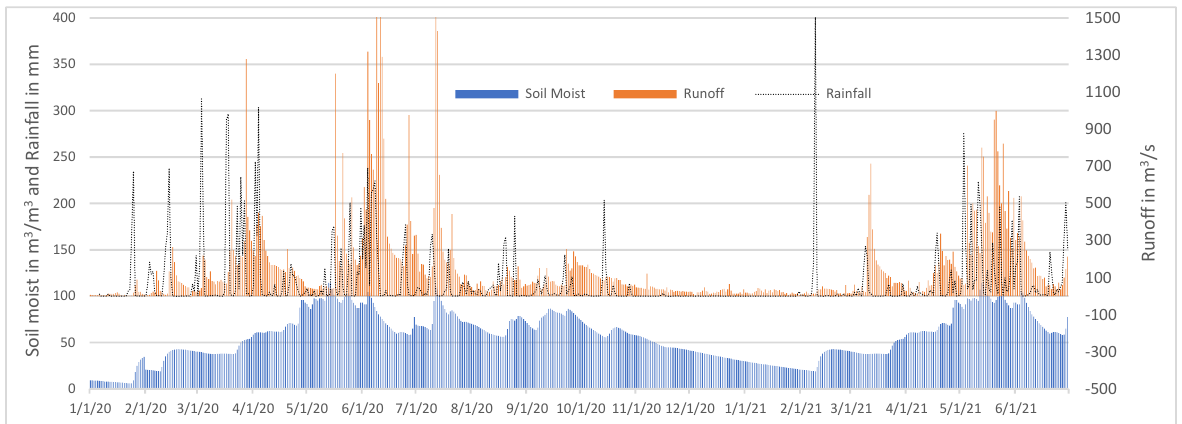
Figure 7. Daily soil moisture and runoff vs. rainfall in Guilin for 1.5 years. Soil moisture values are − 300.